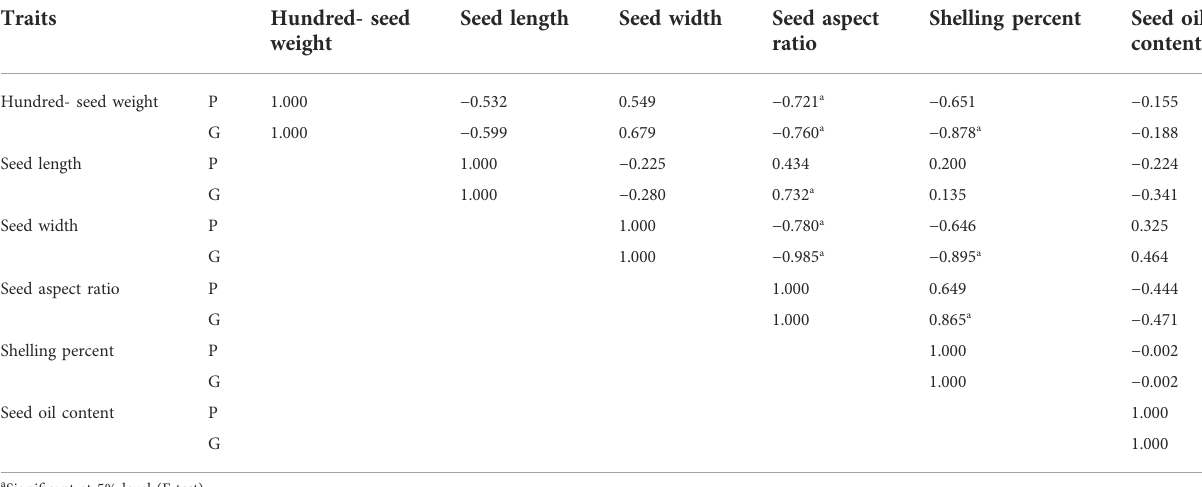
a Signi fi cant at 5% level (F test).